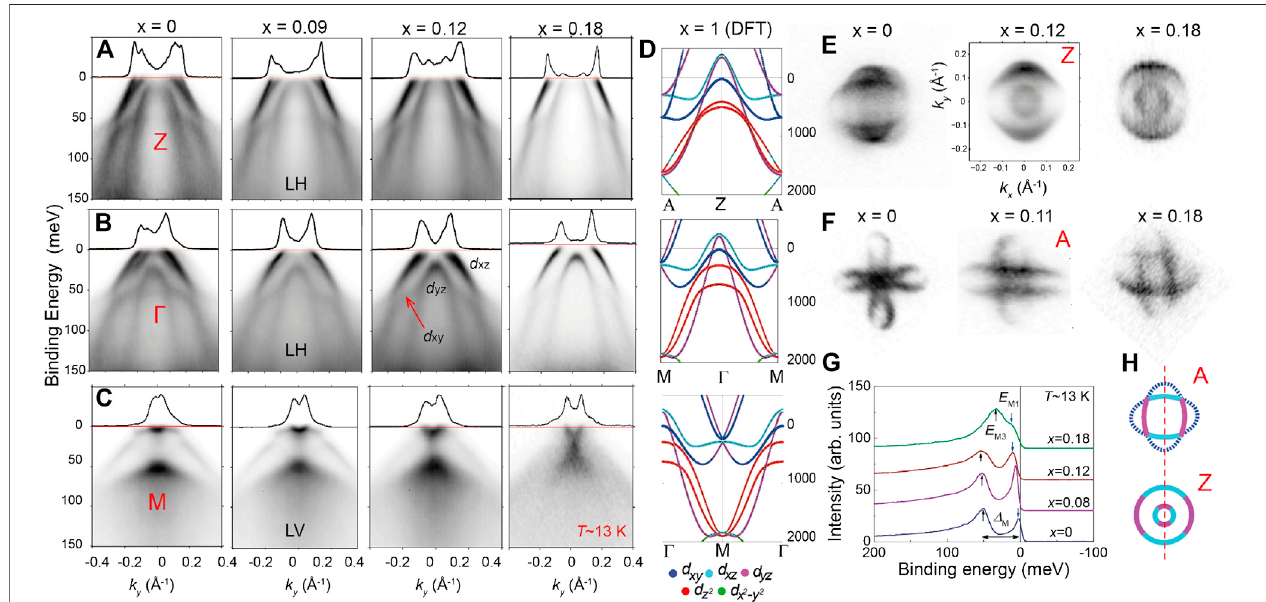
FIGURE 2 | Low-temperature ARPES data for FeSe 1 − x S x . Band dispersion around high symmetry points, (A) Γ , (B) Z , and (C) M collected using horizontally and vertically linearly polarized synchrotron light (LH and LV) at low temperatures at 13 K for different x compositions (after Refs. 29, 35, 40). Momentum dependent cuts (MDCs) are shown above each dispersion which allows to extract the k F values at the Fermi level (the instrumental resolution is ∼ 3 meV). The top of the parabolic band dispersion for the outer hole band at the Γ point for x (cid:2) 0.18 is getting closer to the Fermi level ( ∼ 5 meV) compared with FeSe ( ∼ 17 meV). (D) DFT calculations high symmetry cuts for FeS for the same symmetry points like the ARPES data with energies in meV. These dispersions can be compared with experiments to extract the renormalization factor foreachband. Thecolorsindicate thedifferentorbital character.TheFermisurfacemap fortheholebandsattheZ pointin (E) and fortheelectron bands at the A point in (F) , after Refs. 29, 35, 40, and 58. Inside the nematic phase, the existence of twining below T s can cause superposition of the signal from two domains,rotatedby90 ° .Theorbitalcharacterofthemapvaries aroundtheFermi surfaceasdepicted forthetetragonal casein (H) .Thedashed lineindicates thecutsin (A – C) and theorientationofthemapsin (E) and (F) . (G) Theenergy dependent cuts(EDCs) centeredat thehigh symmetryMpoint fordifferent composition. Theenergy separationbetweenthetwomostintensepeaksisde fi nedby Δ M ,aproxyfortheorbitalorderingeffect.ThepositionsofthehighsymmetryM1andM3pointsfor x (cid:2) 0.18 areindicatedbyarrows. (H) SchematicofthetetragonalFermisurfacesintheZ-Aplanecontainingdifferentorbitalcharacters.Thedashedlineisacutalongthediagonal of the unit cell used in the ARPES measurements in panels a – c.